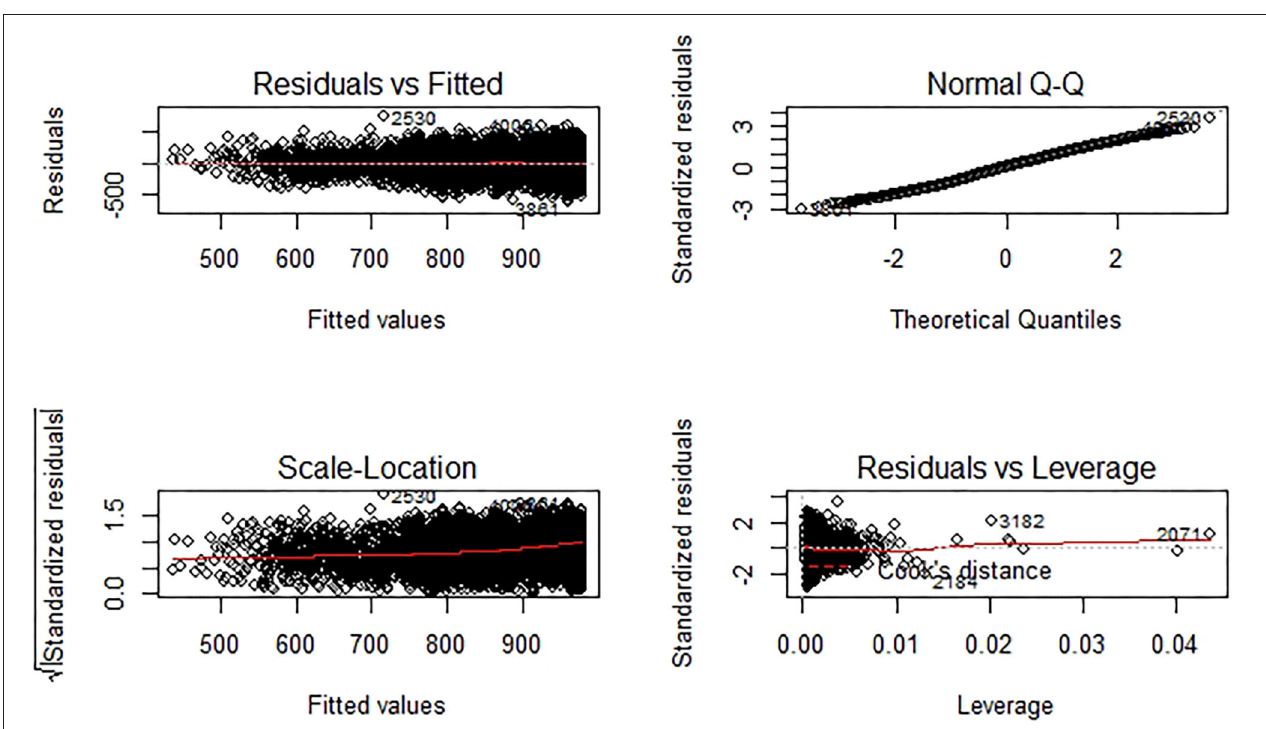
FIGURE A1 | Model diagnostics of the core regression model. The plot entitled, “Normal Q-Q” shows a Quantile-Quantile (Q-Q) plot.